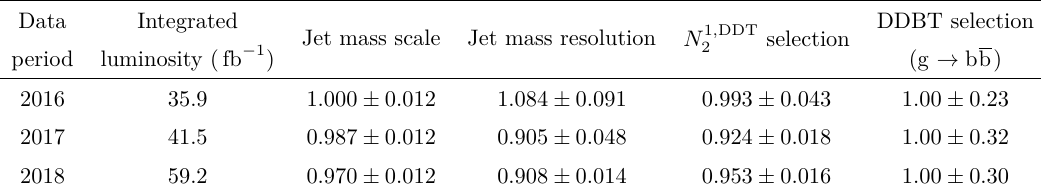
Table 1 . Summary of applied data-to-simulation scale factors for the jet mass scale, jet mass resolution, N 1 , DDT